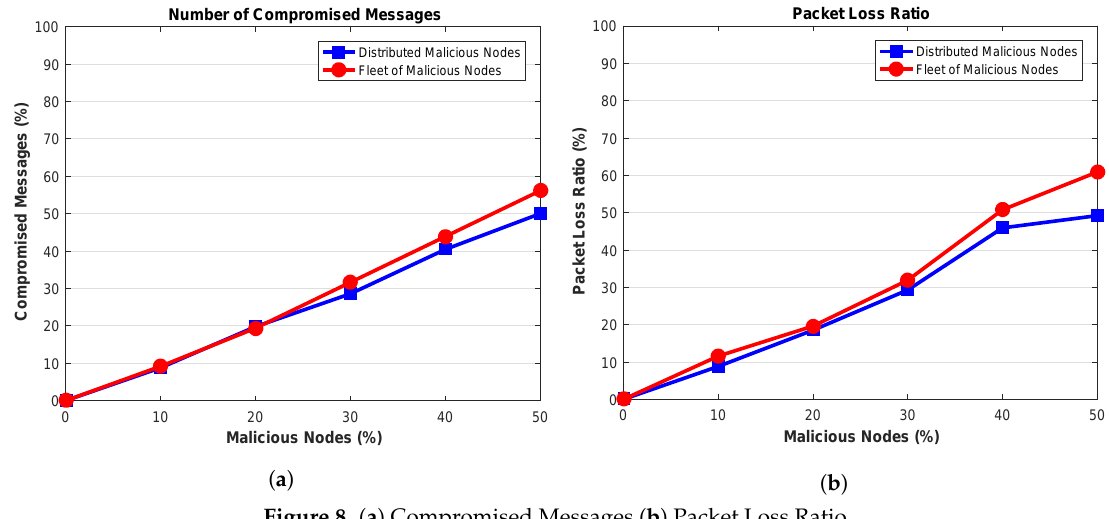
Figure 8. ( a ) Compromised Messages ( b ) Packet Loss Ratio.